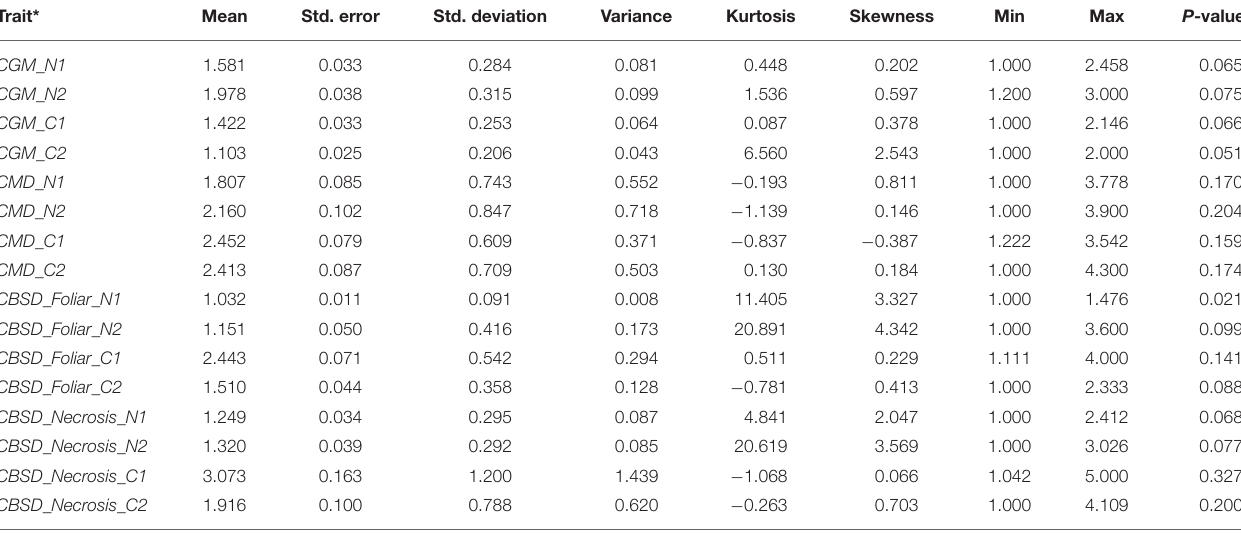
TABLE 1 | Descriptive statistics for phenotypic data for two years 2013–2014(1) and 2014–2015(2) for two sites, Chambezi (C) and Naliendele (N) in Tanzania.